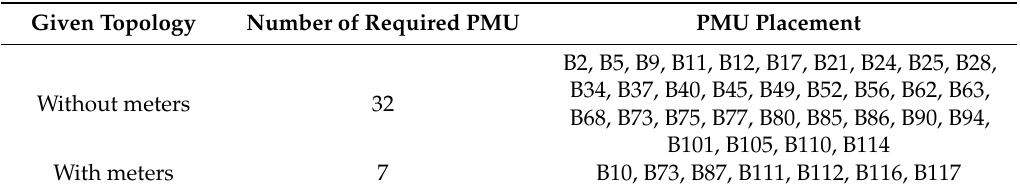
Table 3. PMU placement to ensure cyber security with / without conventional meters in IEEE 118-bus system.